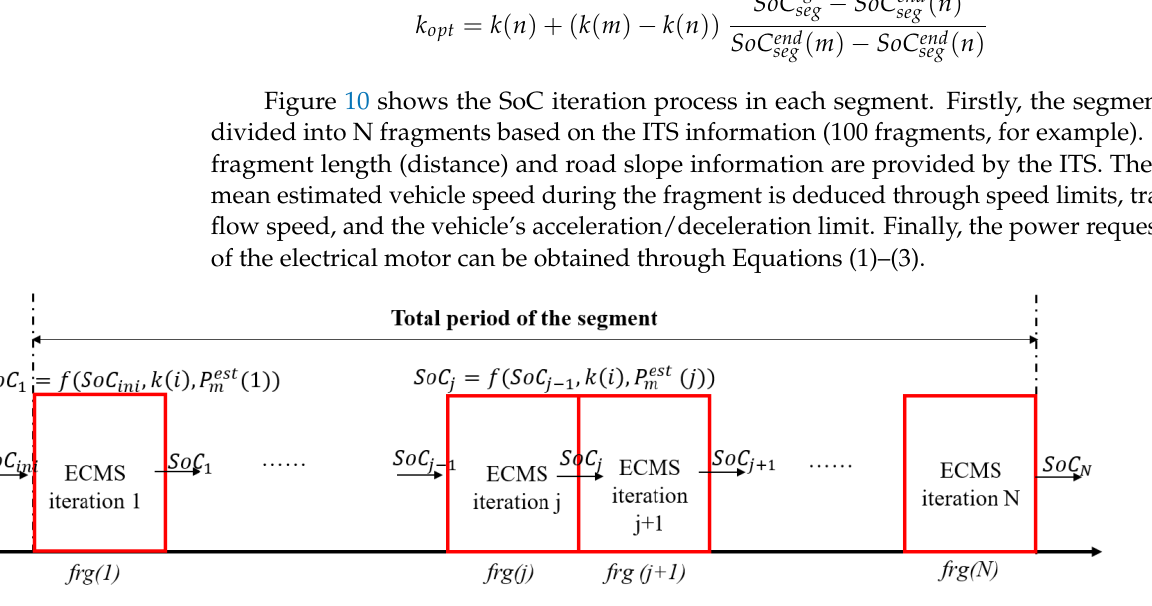
Figure 10. The diagram of ECMS iterative optimization.